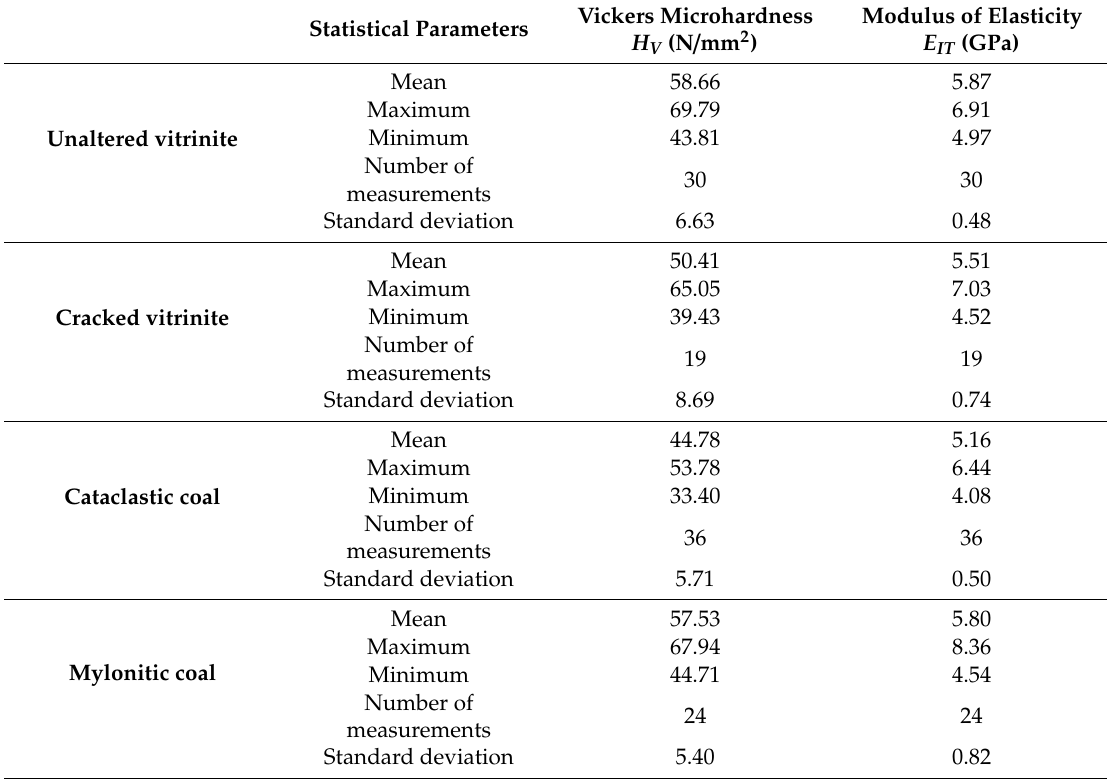
Figure 5. Values of the Vickers microhardness for the analyzed coal samples. Table 3. Statistical parameters of microhardness determined for particular structural types of coal.